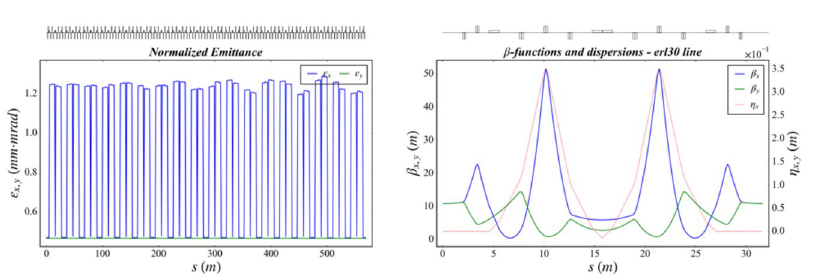
Figure 8. The emittance evolution (left) and the optical function in each TBA cell (right).